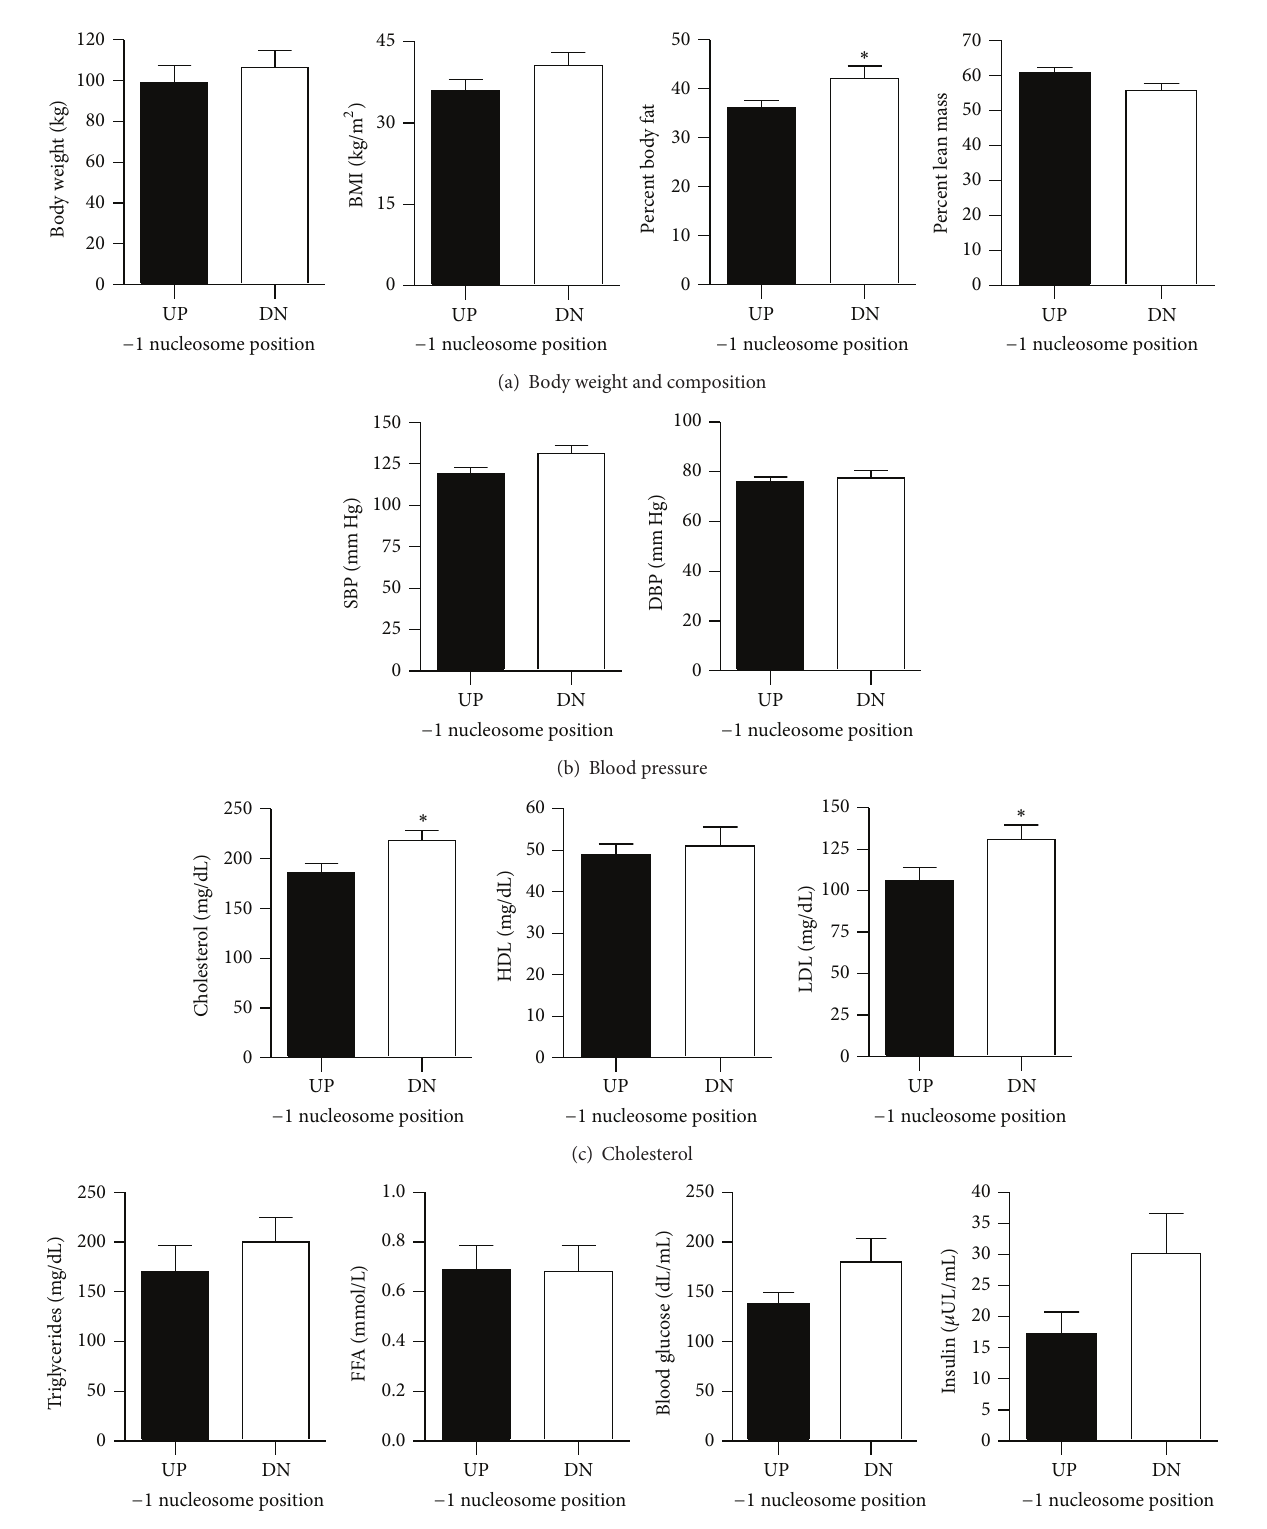
Figure 3: Anthropometric measures in individuals with alternate − 1 nucleosome positioning within the PGC1 𝛼 promoter. Individuals were divided into upstream (UP, black) and downstream (DN, white) groups and (a) body weight, body mass index (BMI), and percent body fat and lean mass, (b) systolic (SBP) and diastolic blood pressure (DBP), (c) total, high density lipoprotein (HDL), and low density lipoprotein (LDL) cholesterol, and (d) plasma triglycerides, free fatty acids (FFA), glucose, and insulin were analyzed by Student’s 𝑡 -test and are shown as mean ± SEM. ∗ indicates significance difference between groups with 𝑃 < 0.05